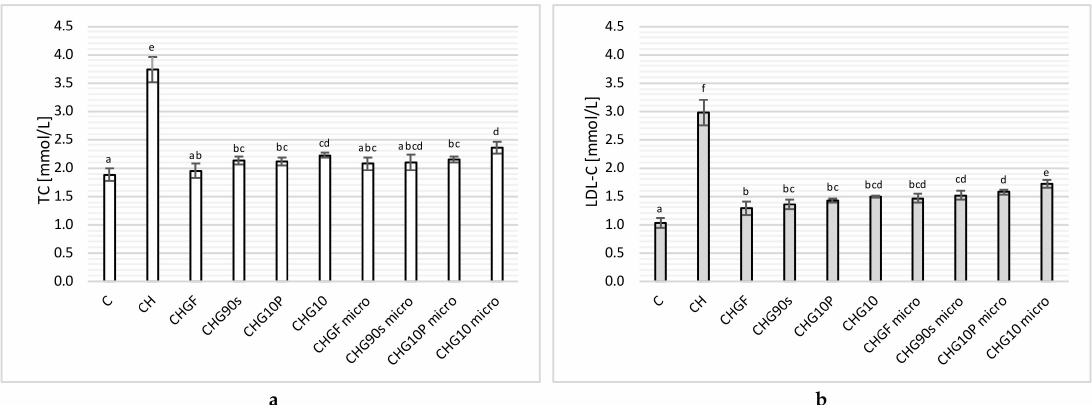
Figure 1. Influence of freeze-dried fresh and thermally processed garlic on plasma lipid profile: total cholesterol (TC— a ) and LDL cholesterol (LDL-C— b ) content in rats fed control- and cholesterol- containing (1% of cholesterol) diet during the 28 day experiment. Values are means ± SD ( n = 6). Means in bars with different letters are significantly differ ( p < 0.05); Tukey’s